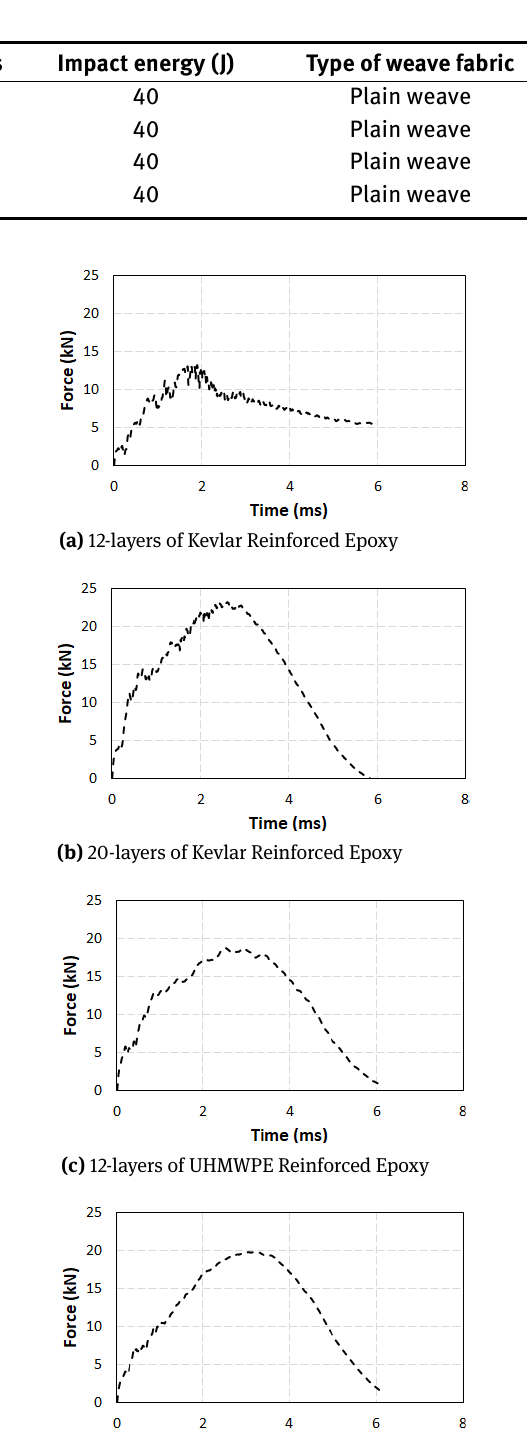
Table 2: Specimens tested of composite material